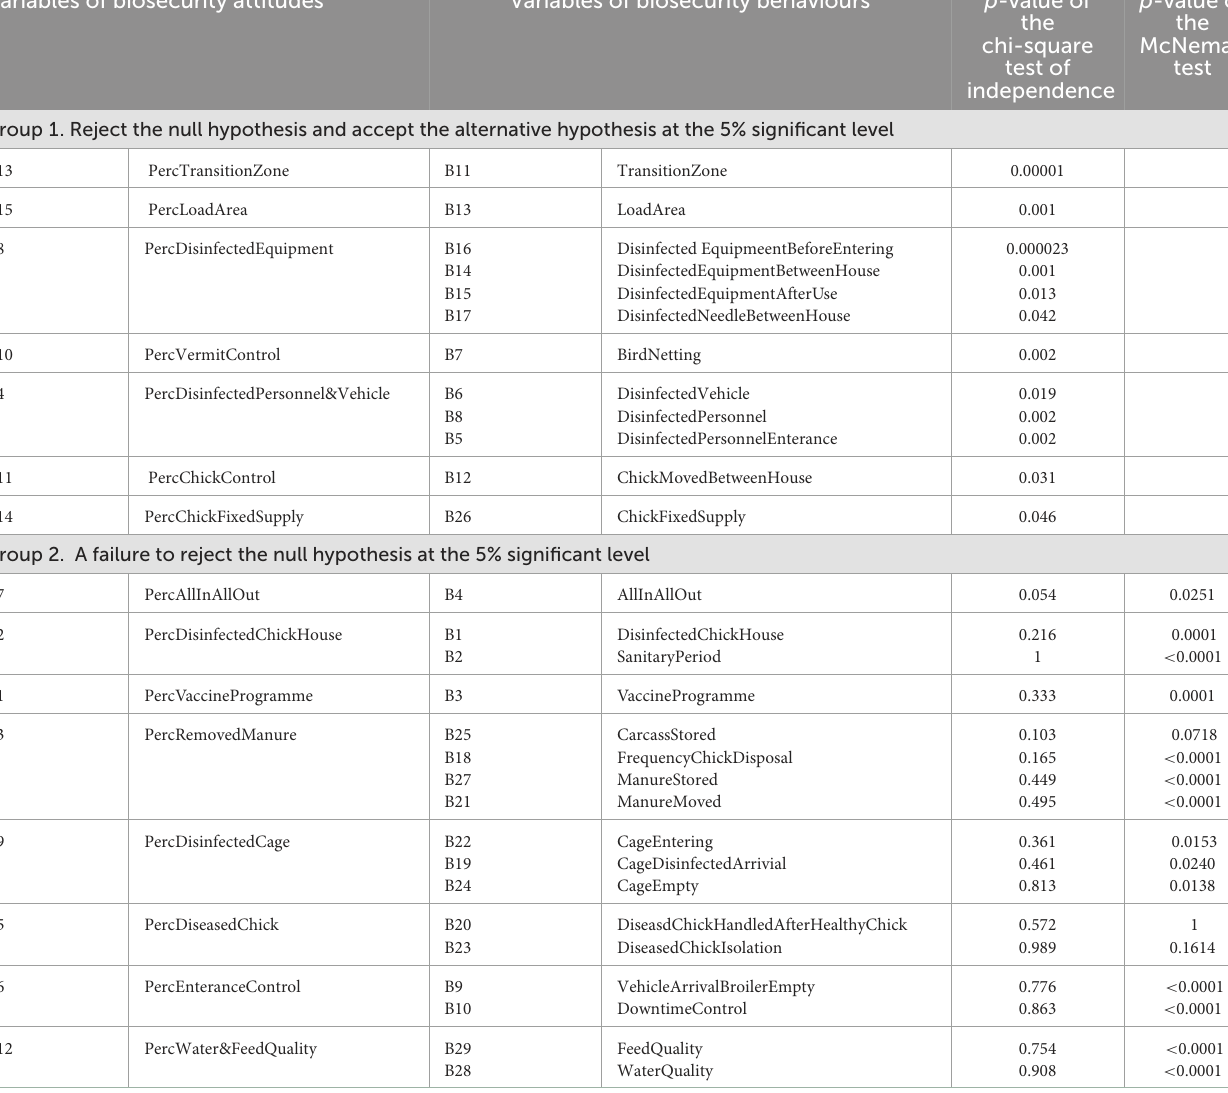
TABLE 3 The statistical associations of farmers’ biosecurity attitudes and their relevant biosecurity behaviours. Variables of biosecurity